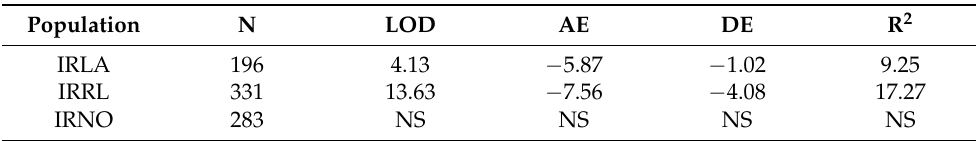
Table 3. Validation of qRCA4 effects across different genetic backgrounds using F 2 populations derived from IRAT109.